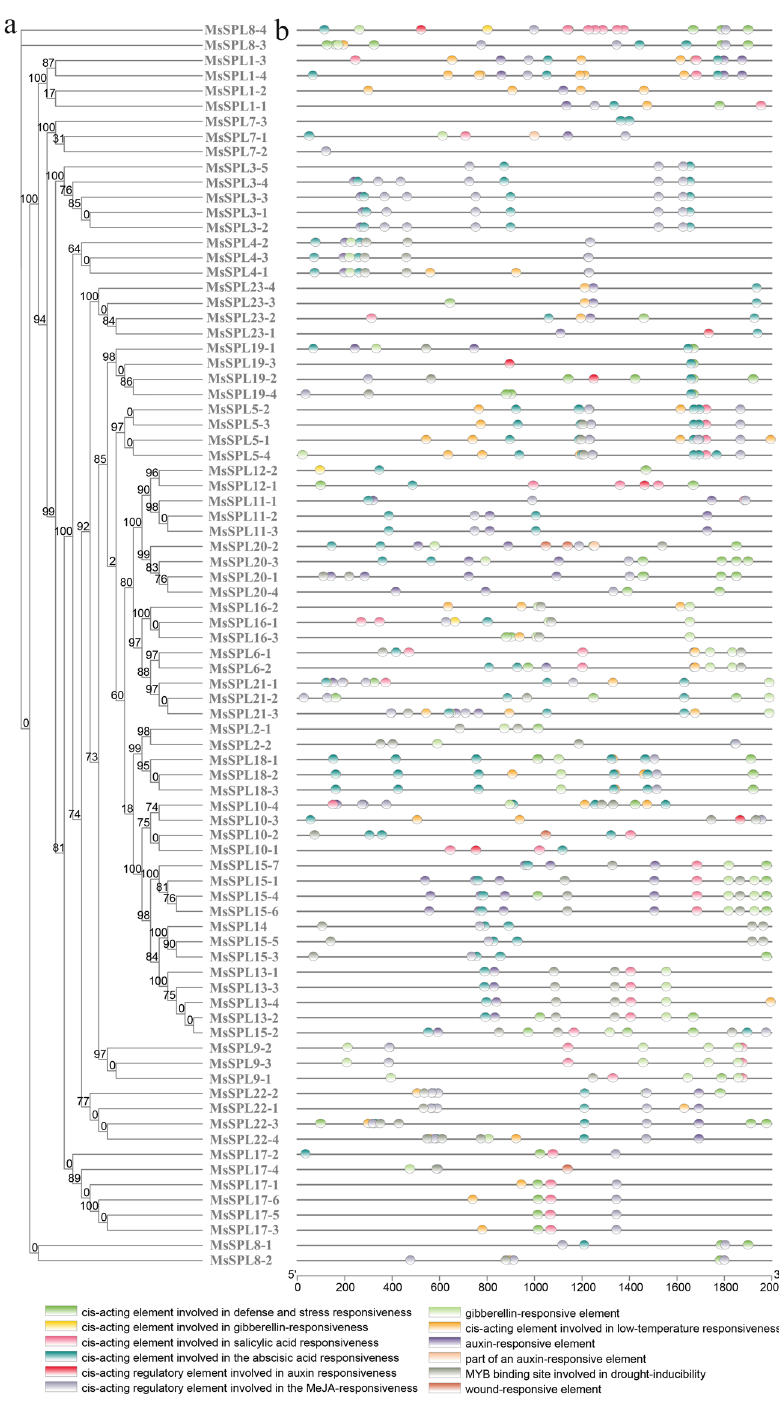
Figure 4. MsSPL promoter cis-acting element. ( a ) Alfalfa SPL evolutionary tree; ( b ) distribution of cis-acting elements in promoters of alfalfa SPL gene family. Different colored squares show different promoter cis-acting